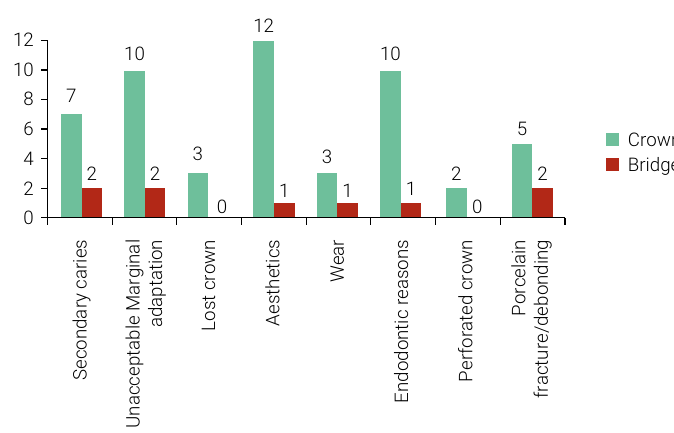
Figure 1. Reasons for replacement of crowns and bridges among patients